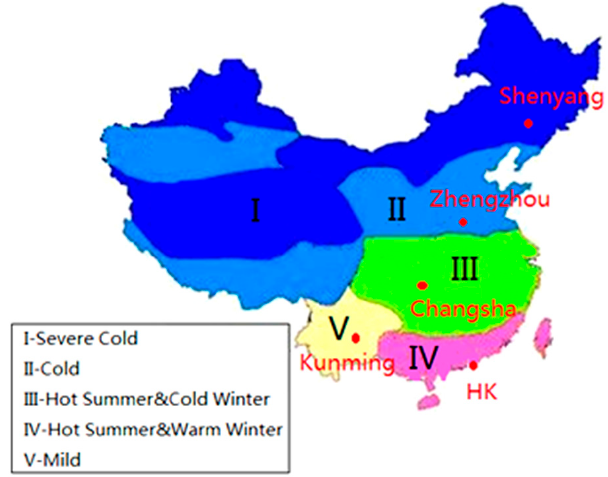
Figure 4. Different climate regions in China. Table 2. Temperature characteristics for China in five different climate regions [28].